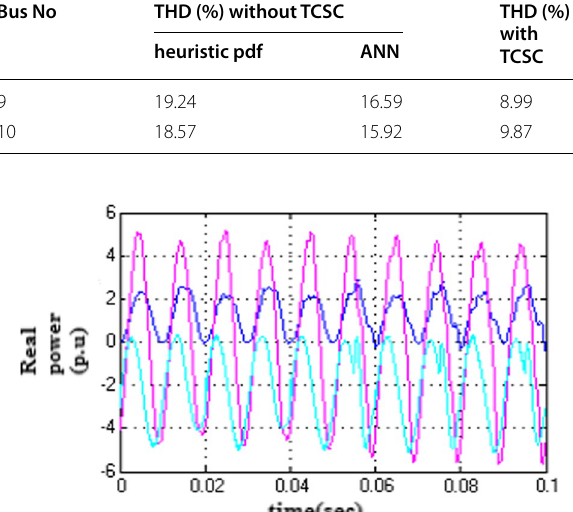
Fig. 11 Real power flow between buses 9 and 10 with TCSC for IEEE 57 bus system